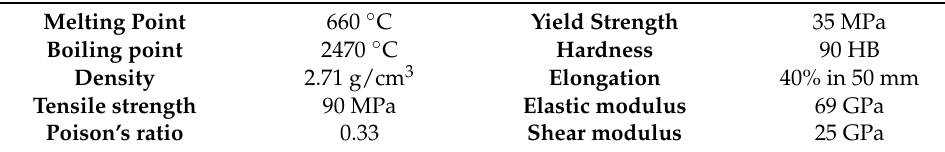
Table 2. Different physical properties of pure aluminum at room temperature.